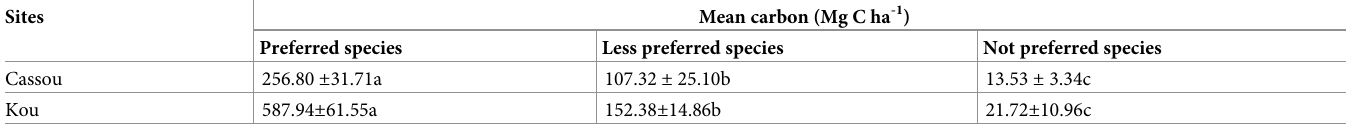
Table 8. Mean values of carbon potential of the preferred, less preferred and not preferred species by the respondents across Cassou and Kou in Ziro province in Burkina Faso.